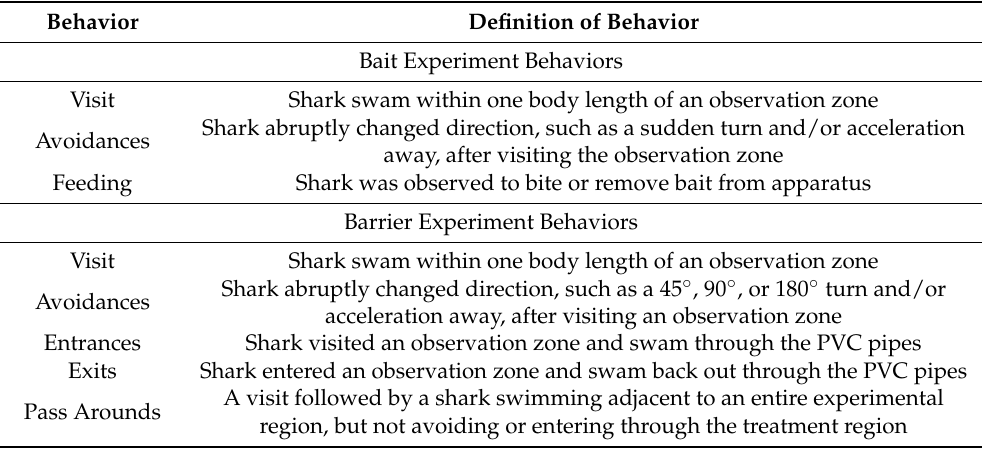
Figure 1. Aerial drawing of the experimental setup for the bait experiment. This experiment consisted of two, 1.5 m 2 observation zones, one associated with each treatment: the control and the magnetic. The control consisted of a non-activated DC 12V 180N electromagnet placed in the center of the observation zone. The magnetic contained an activated DC 12V 180N electromagnet, powered by a 12V shoreline power source. In the center of each observation zone and in combination with the electromagnetic treatments, a clip was used to facilitate the attachment of 0.11 kg of bonito ( Sarda sarda ; not included in the figure). Table 1. Behavioral ethogram. This table describes the bull shark ( Carcharhinus leucas )-associated behaviors for both bait and barrier experiments.